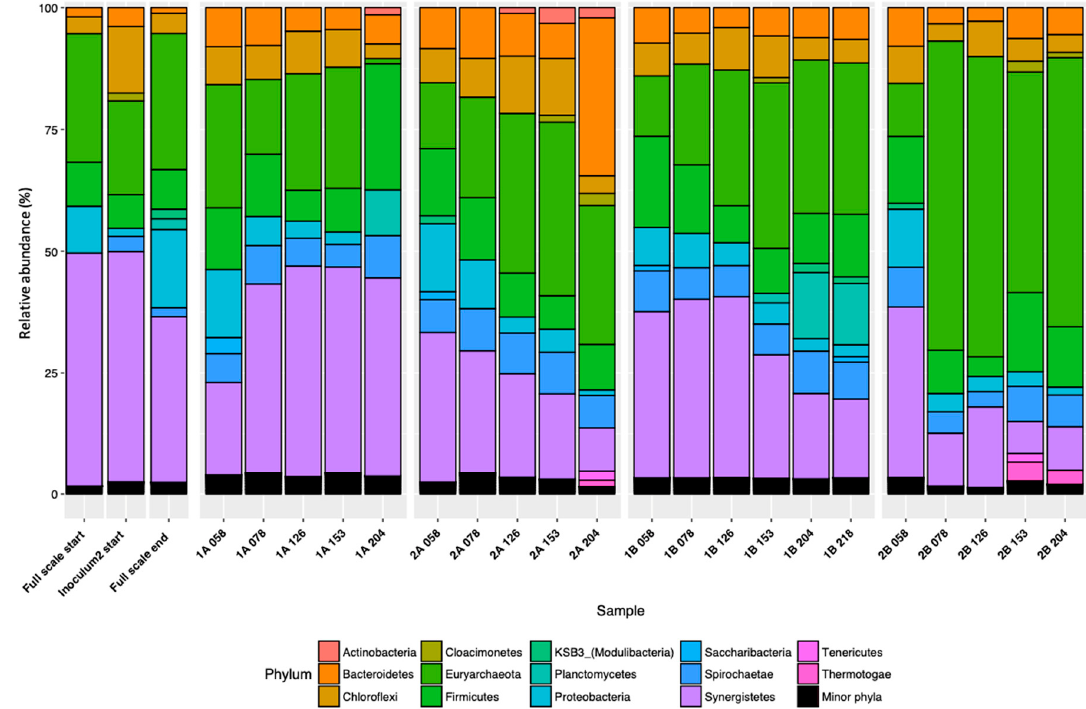
Figure 5. Relative abundance of microbial 16S rRNA genes at phylum level in upflow anaerobic sludge blanket (UASB) reactors 1A, 1B, 2A, and 2B, arranged by operating day (day 58, 78, 126, 153, 204, and additionally, day 218 for 1B) and the inoculum used for reactor set-up (two types of granules, labeled ‘Full scale start’ and ‘Inoculum2 start’), and granules from the same full-scale plant when our experiment ended, labeled ‘Full scale end’. Phyla present in relative abundance less than 1% are merged into ‘Minor phyla’ (The data presented in Figure 5 are also visualized as an abundance heatmap in Figure S6).